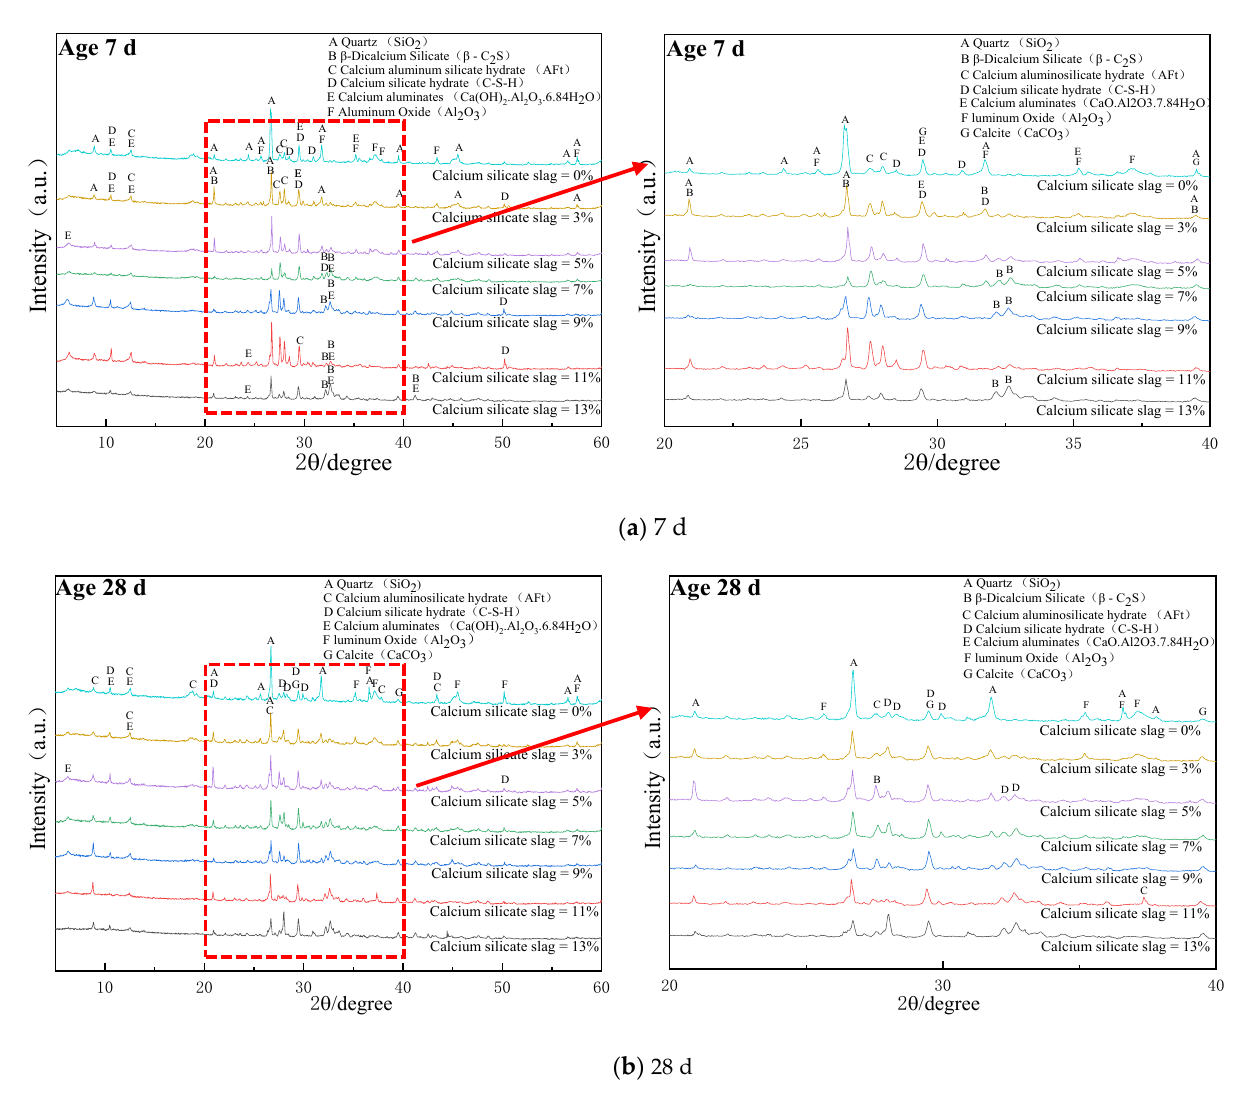
Figure 4. XRD patterns under different dosages of calcium silicate slag: ( a ) XRD analysis of curing for 7 d, ( b ) XRD analysis of curing for 28 d.